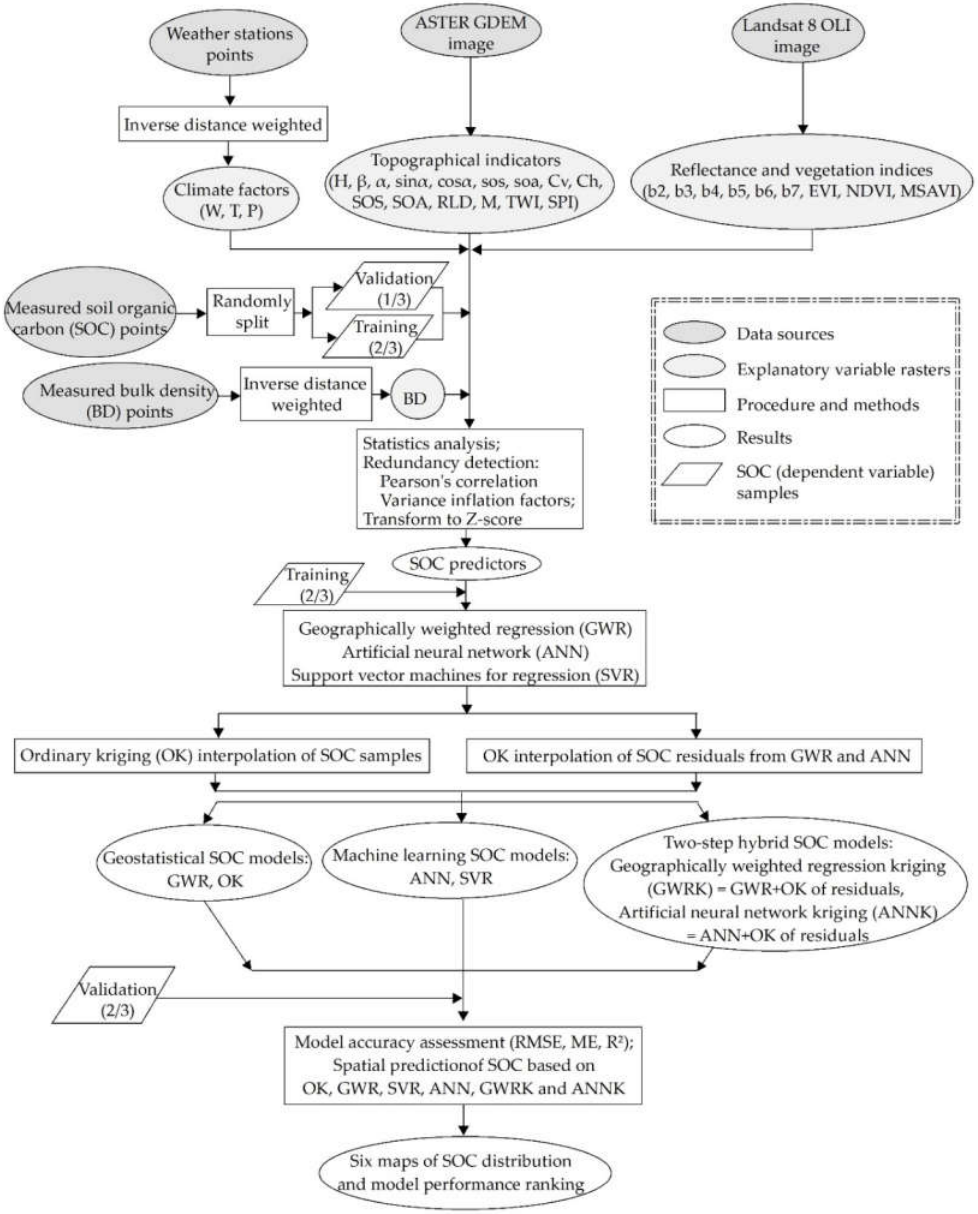
Figure 2. The flow chart of the comparative assessment of geostatistical, machine learning, and hybrid approaches for mapping topsoil organic carbon content.